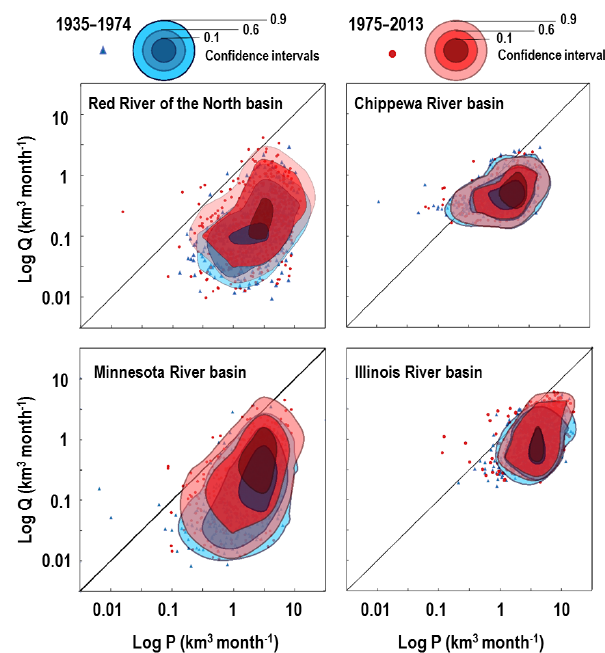
Figure 8. Log–log empirical quantiles of joint PDF plots of monthly streamflow ( Q ) versus monthly precipitation ( P ) volumes for each river basin during the pre-period (blue: 1935–1974) and post-period (red: 1975–2013); bulls eye shading represents the 0.1 (dark), 0.6 (medium), and 0.9 (light) confidence